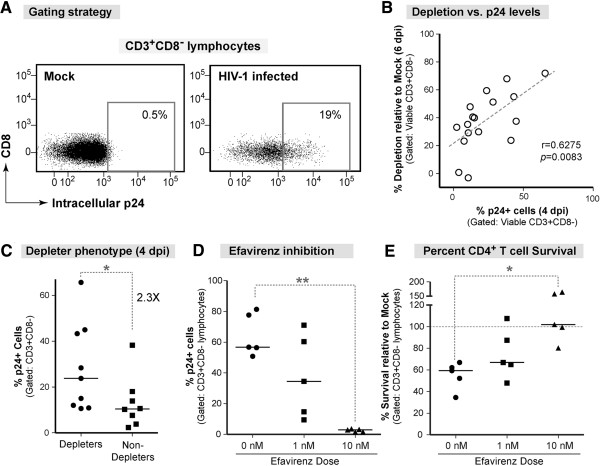
Relationship between HIV-1 infection and LP CD4+ T cell depletion. (A) Representative flow plots identifying p24+ cells using the gate established in mock infection (<1%). The net frequency of p24+CD4+ T cells (e.g.,%p24+ =%p24+ in HIV-1 minus %p24+ in Mock) is reported. (B) Spearman rank correlation analysis between the percentage of p24+ cells at 4 dpi and the level of LP CD4+ T cell depletion at 6 dpi. The best-fit line, Spearman r and the p value are indicated. (C) The percentage of p24+ cells was compared between ‘depleters’ and ‘non-depleters.’ Each point is a unique sample. The horizontal solid line indicates the median infection level. Statistical significance was determined by Mann–Whitney U test, *p = 0.03. (D-E) LPMCs were pre-treated with Efavirenz for 2 h prior to infection with HIV-1Ba-L or mock and re-dosed at 3 dpi. The net frequencies of p24+ cells (overall ANOVA p = 0.0008) were calculated for each donor at 6 dpi (Figure 2D). The percentage of CD4+ T cells surviving relative to mock infection in the presence of Efavirenz is shown (overall ANOVA p = 0.0394) (Figure 2E). The medians are shown and the dashed horizontal line indicates 100% survival relative to mock infection. Statistically significant differences were determined using the Friedman Test and Dunn’s Multiple Comparison test to compare between groups.